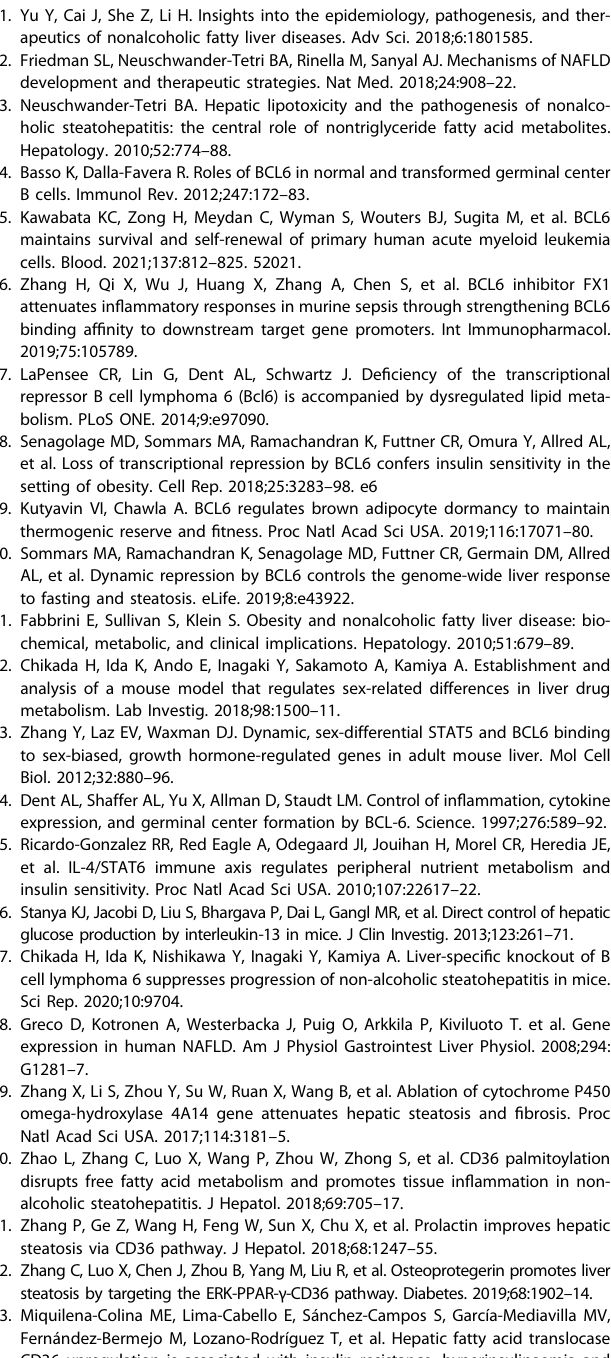
Fig. 8 CD36 reversed the phenotype induced by BCL6 overexpression. A A Schedule of manipulating the overexpression of CD36 and BCL6. Six-week-old mice were injected with AAV-Control, AVV-BCL6, AAV-Control + AAV-CD36, or AAV-BCL6 + AAV-CD36 via the tail vein and fed an HFD. B Protein level of CD36 and BCL6 in livers of the mice from the indicated groups after being injected with AAV. C Bodyweight, ( D ) food intake, and ( E ) LW/BW of the mice from the indicated groups ( n = 6/group). F Representative images of H&E and Oil red O staining of liver tissues from the mice from the indicated groups. Scale bar, 100 μ m. G Total cholesterol, H triglyceride, I NEFA, J ALT, and ( K ) AST levels in the livers from the mice of indicated groups fed an HFD for 16 weeks. ( n = 6/group). L Representative images of immunohistochemistry staining of F4/80 of liver tissues from four group mice. Scale bar, 100 μ m. M Protein level of CD36 and BCL6 in LO2 cells after transfected adv-Control, adv-BCL6, adv-Control + adv-CD36, or adv-BCL6 + adv-CD36. N Representative images of Oil red O staining of LO2 cells of indicated groups stimulated with PA (0.3 mM) for 24 h. Data represent the mean ± SEM, * P < 0.05, ** P < 0.01, *** P < 0.001 and n.s. indicates no signi fi cance between the two indicated